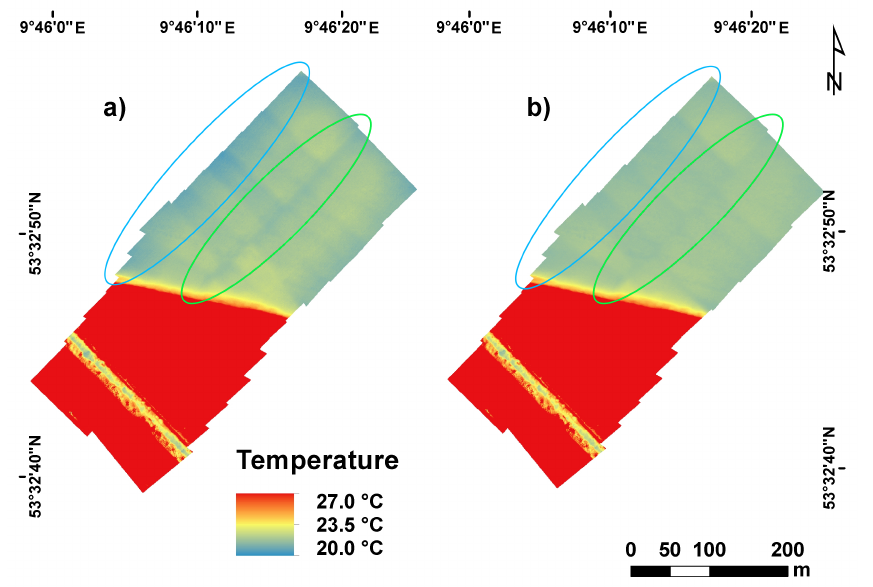
Figure 8. Example mosaic of hexacopter images before ( a ) and after ( b ) camera correction. The de- creasing temperature values at the borders of the individual images (blue ellipse) and in the overlap- ping image areas in the middle of the mosaic (green ellipse) have markedly